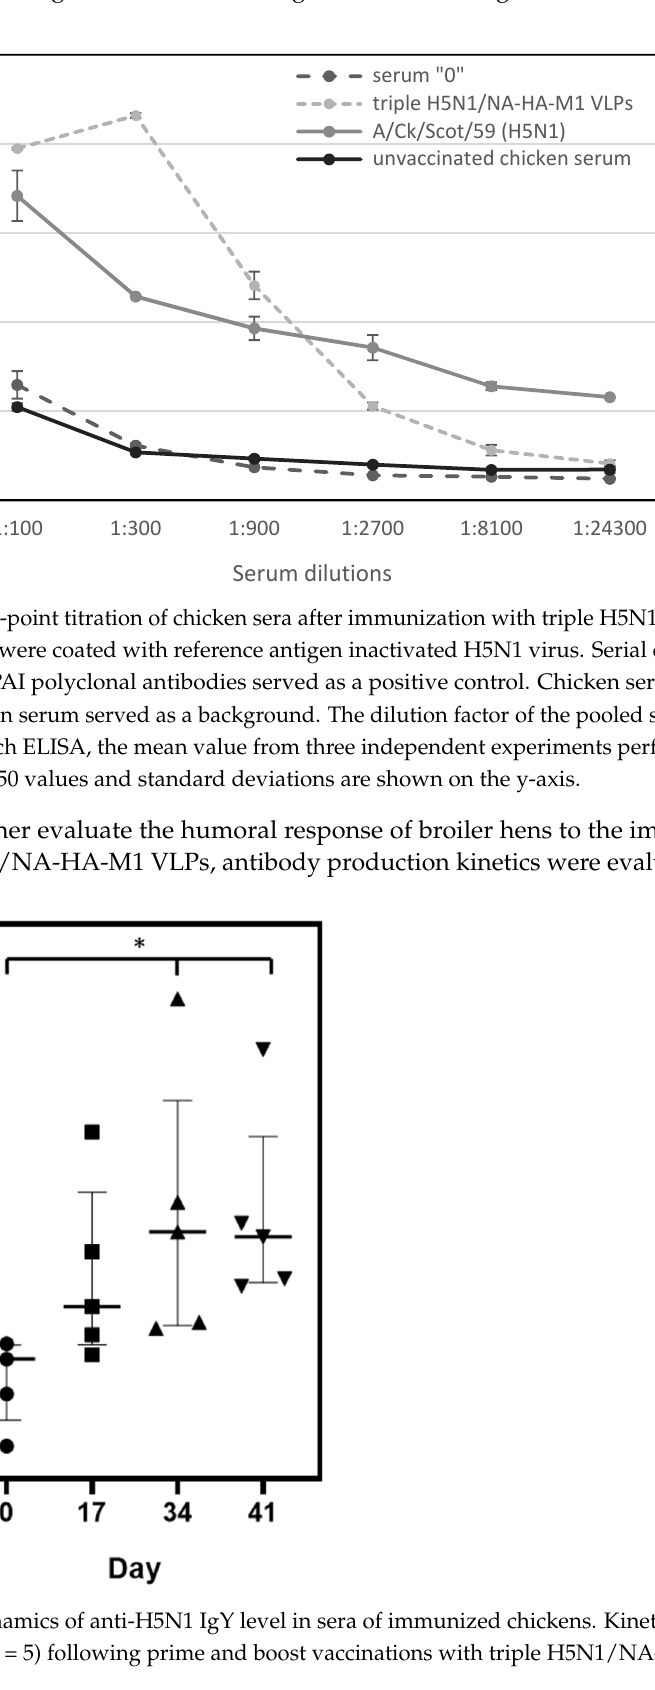
Figure 3. Schematic timeline of immunization of the broiler hens with triple H5N1/NA-HA-M1 VLPs. Red droplets represent the days of blood collection.